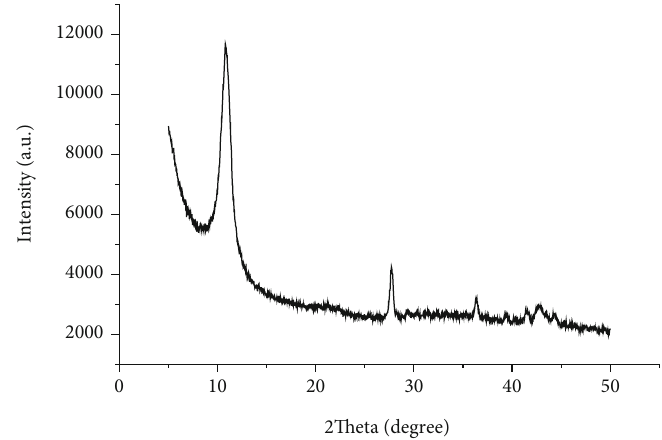
Figure 3: XRD spectrum of as synthesized GFT oxide nanocomposite.